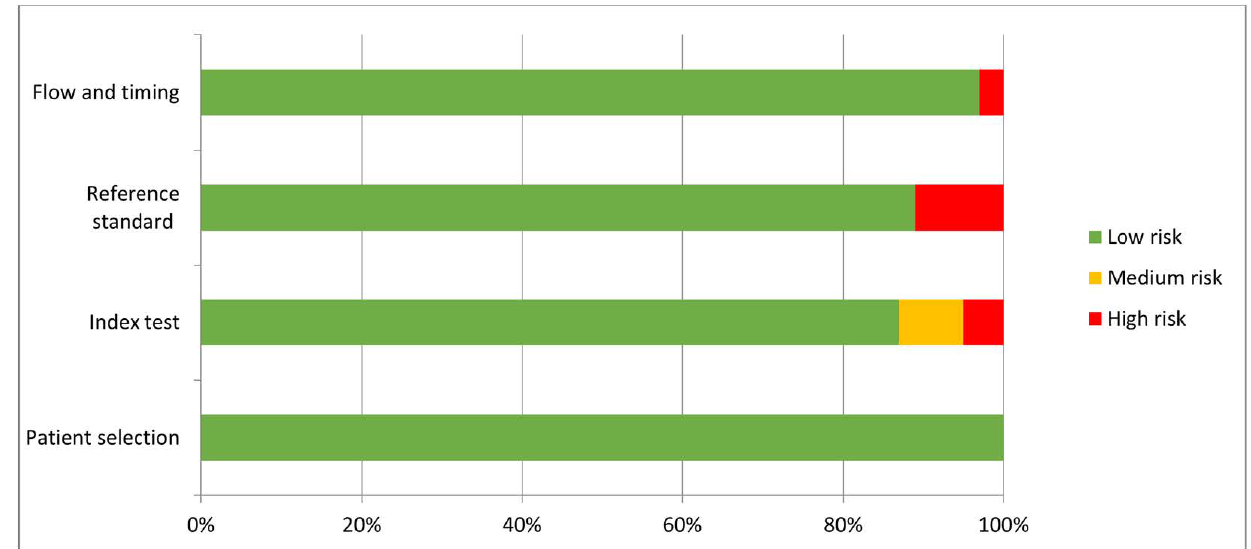
Figure 1. The QUADAS-2 tool for evaluating risk of bias and assess quality of research.